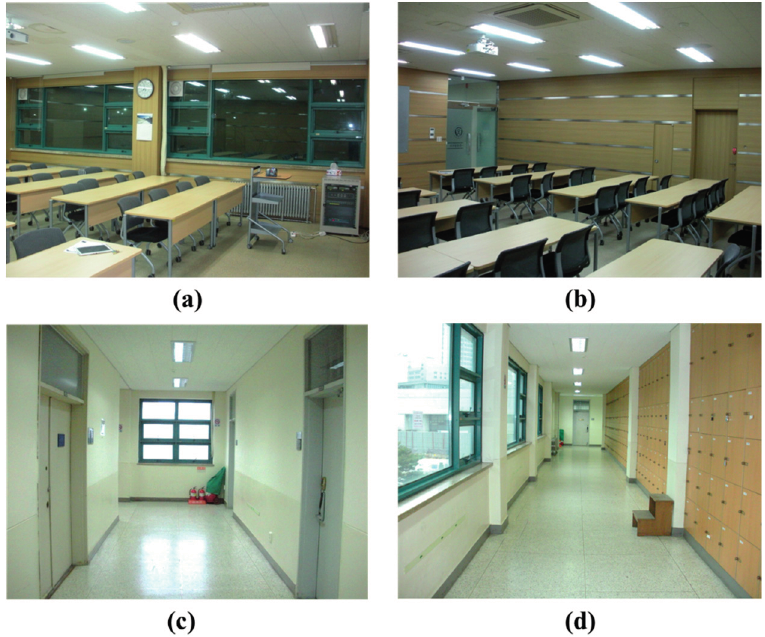
Figure 7. Test sites: ( a , b ) are the seminar room; ( c , d ) are the